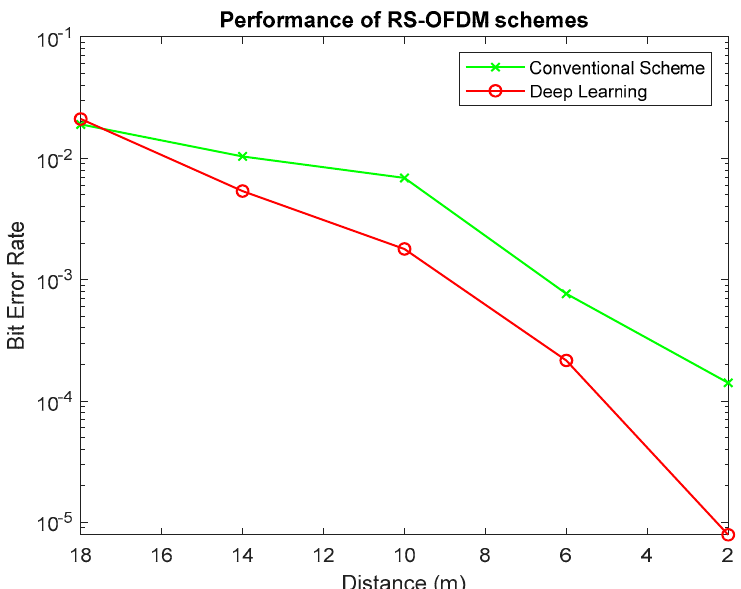
Figure 10. BER performance of RS-OFDM with deep learning and conventional schemes with ve- locity of 2 m/s . of 2